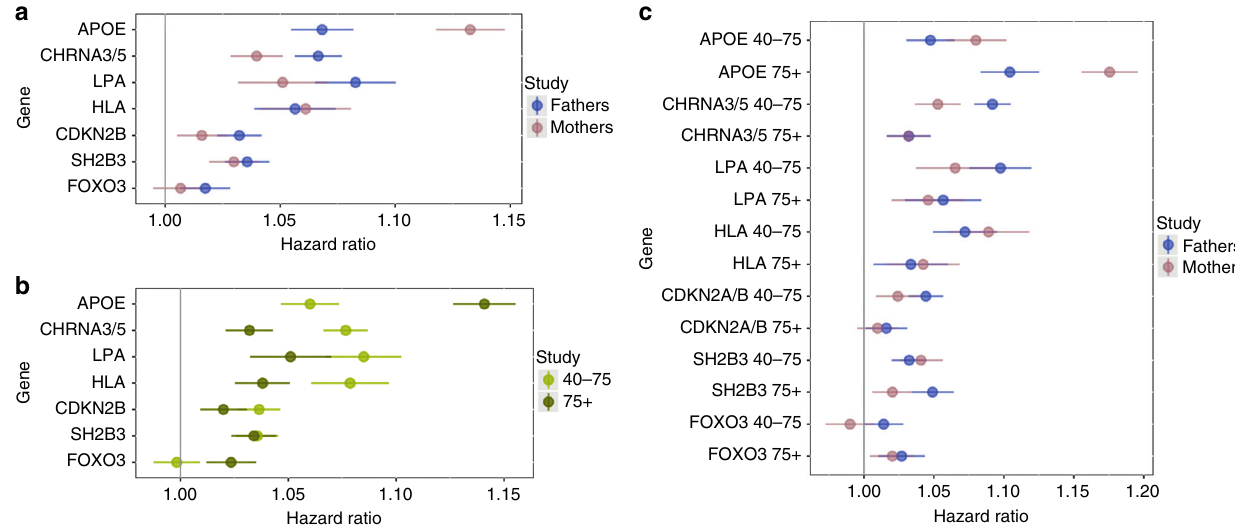
Fig. 4 Age-speci fi c and sex-speci fi c effects of the 4 GWS associations in LifeGen and the validated candidate loci. The four GWS and three suggestive replicated loci were analysed for age-speci fi c and sex-speci fi c effects on lifespan. a The variants at APOE and CHRNA3/5 exhibit sexually dimorphic effects on parental mortality, while all other variants exhibit more modest often non-signi fi cant sex-speci fi c differences. b The effects of each gene on male and female lifespan were meta-analysed and studied in the cases that died aged between 40 and 75 or after 75. APOE exerts a much greater effect in the older age group, while most of the other genes exhibit the opposite effect. FOXO3 appears neutral, if not positive, in the earlier age group. c Effects on mortality were studied in both age groups for both sexes. APOE has the strongest effect on females aged 75+, CHRNA3/5 acts on males aged 40 − 75 and all